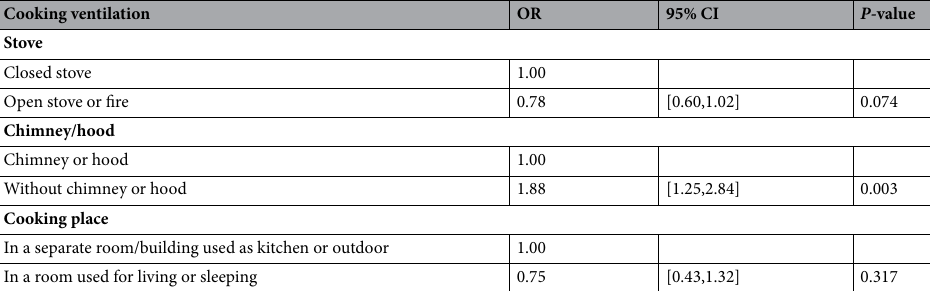
Table 3. Association between cooking ventilation and mild cognitive impairment (outcome) estimated by multivariable logistic regression. Models are adjusted for age, sex, education, wealth, marital status, setting, smoking, alcohol consumption, physical activity, obesity, number of chronic conditions, and country. Sample is restricted to those using solid fuels (coal or biomass fuels). OR odds ratio, CI confidence